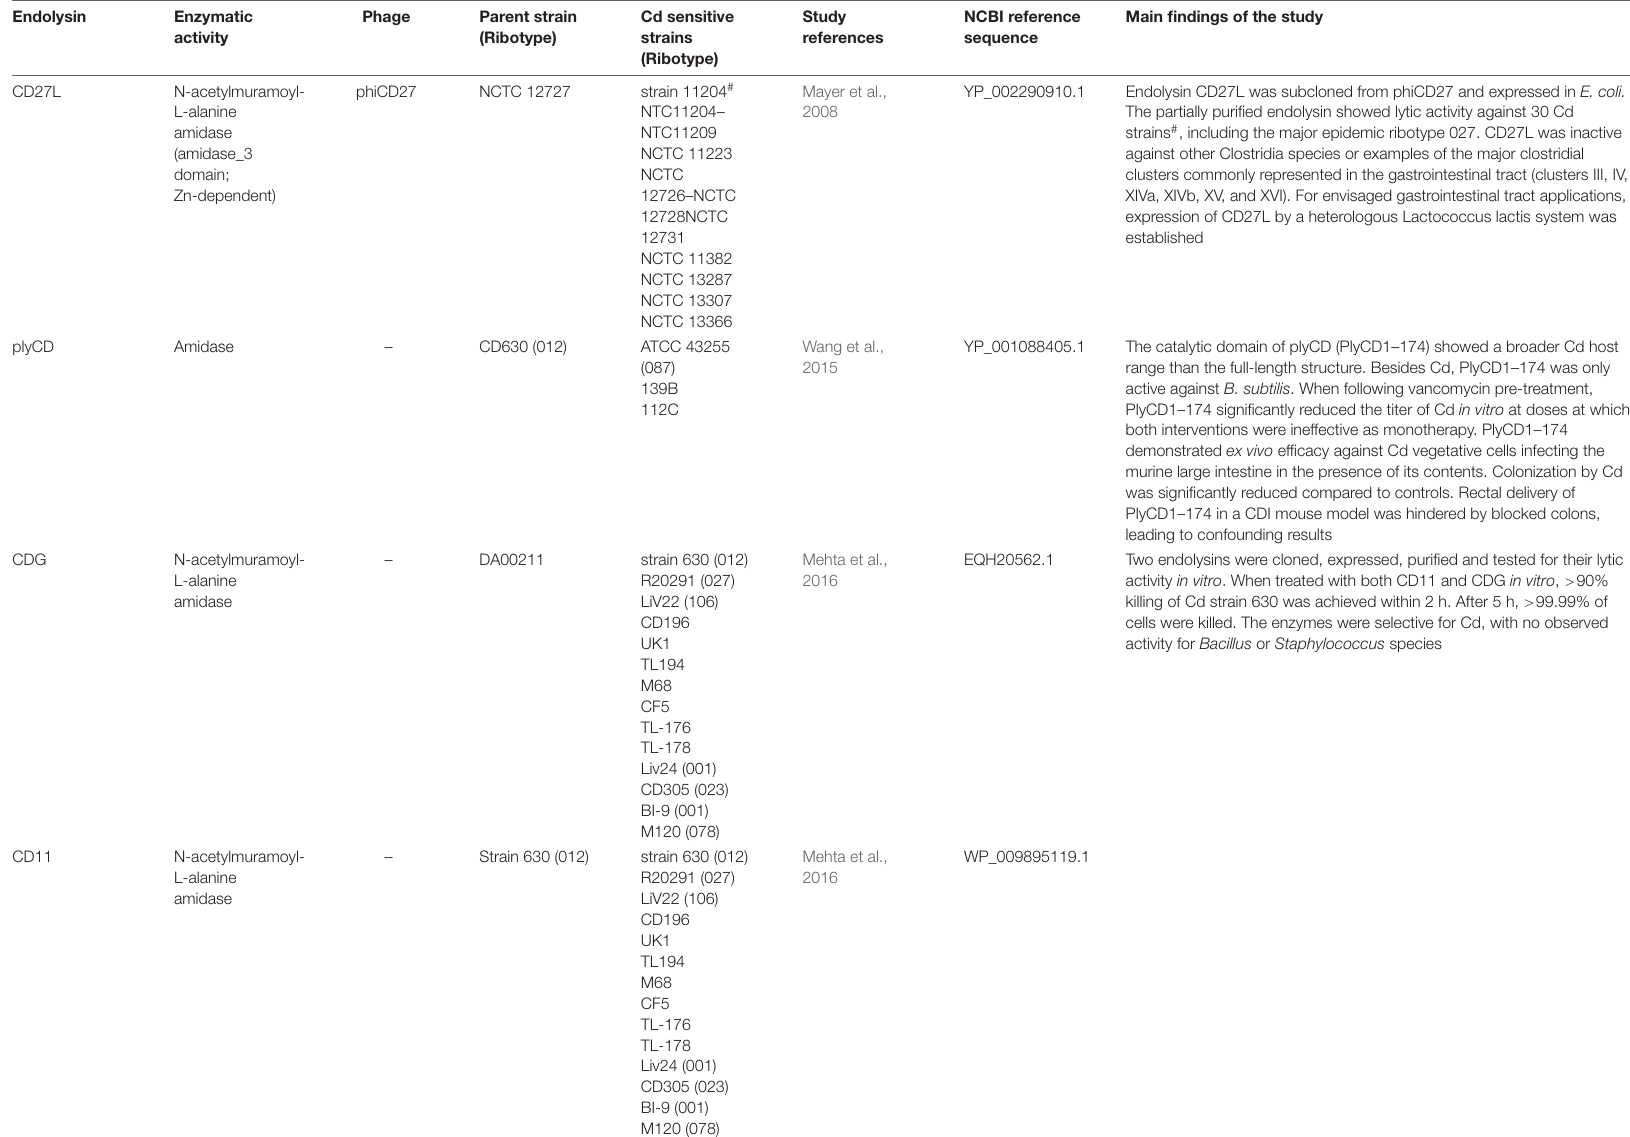
TABLE 2 | Endolysins targeting C. difficile characterized to date, as described in the referenced literature.